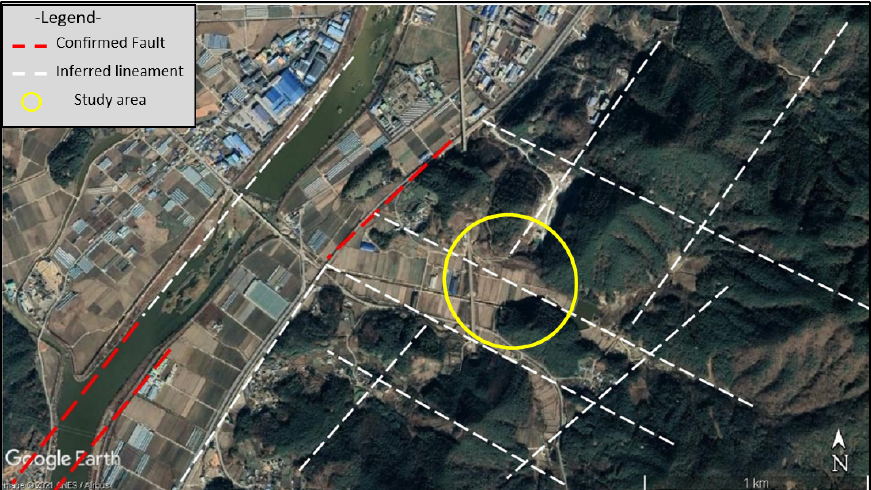
Figure 8. Regional lineaments in the vicinity of the Gun-dong Mine area.